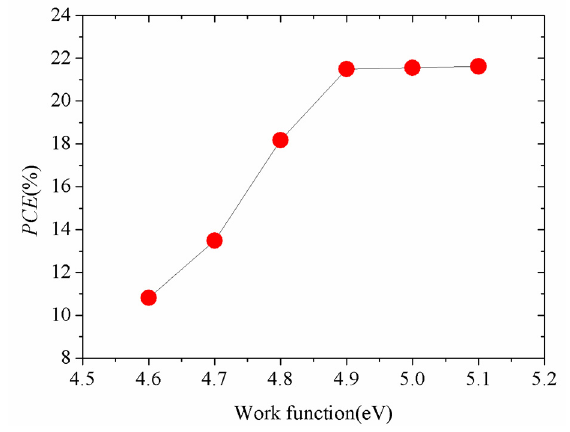
Figure 15. E ff ect of back-contact work function on Figure 15. Effect of back-contact work function on PCE.